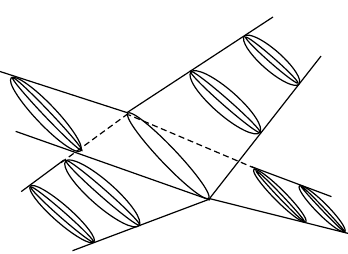
Figure 18. There is an additional contribution to the eight-point function, involving four four- point functions meeting at a melon. This diagram is not planar, so it is di(cid:14)cult to draw. We have shown it for SYK with q =6, unlike the other diagrams in the paper which are drawn for q